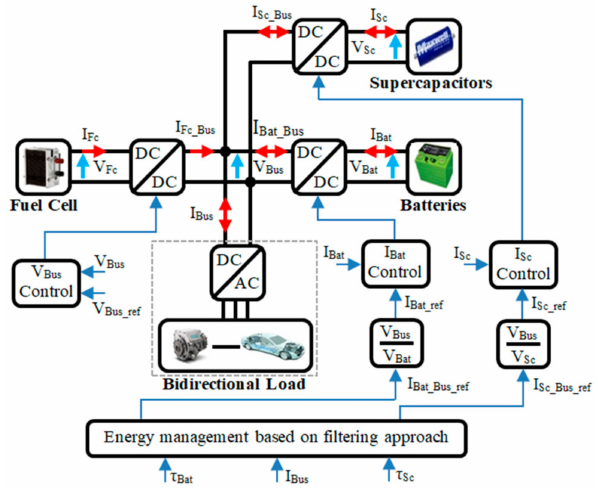
Figure 11. Overall scheme of the EV energy management strategy and power converters